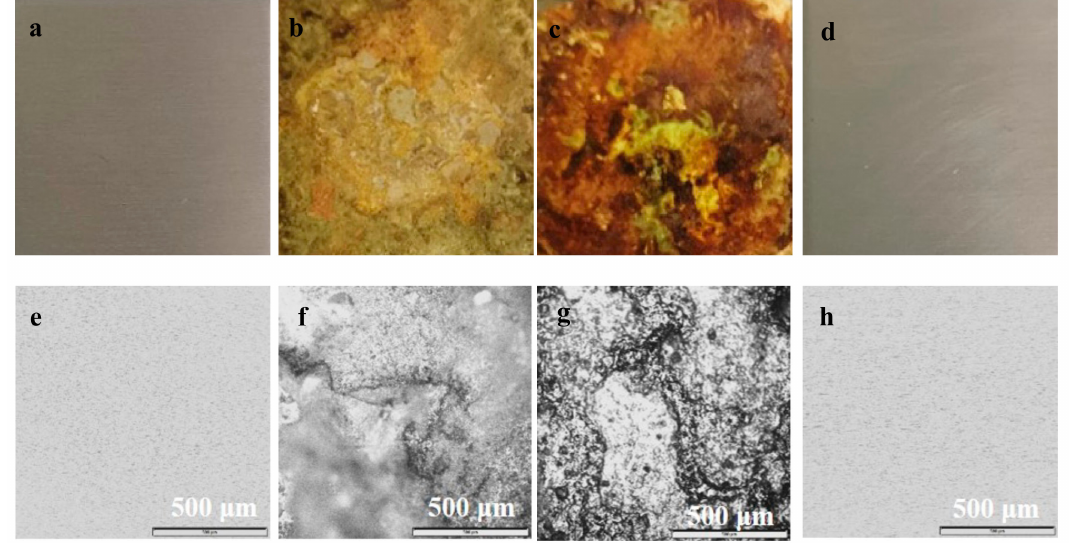
Figure 2. Digital photos ( a – d ) and optical microscope images( e – h ) of the stainless steel slice exposed to different drying atmosphere for different time ( a , e : fresh steel; b , f : trimethylchlorosilane (TMCS) as sole silylation agent, 36 h; c , g : TMCS as sole silylation agent, 60 h; d , h : equimolar mixture of TMCS and hexamethyldisilazane(HMDS) as silylation agent, 36